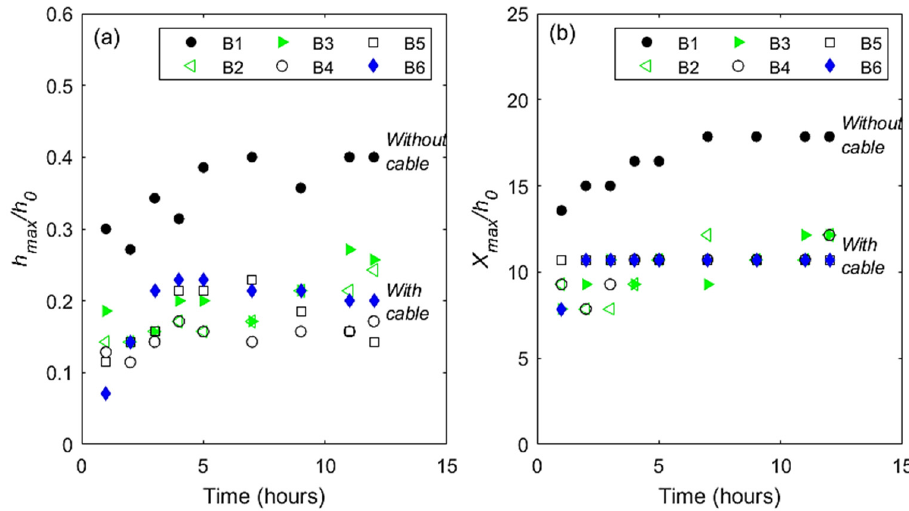
Figure 5. Wake dune height h max ( a ) and downstream position x max , ( b ) normalized with the approach flow depth h 0 for the B1 to B6 test series with sediment d 50 = 0.86 mm.